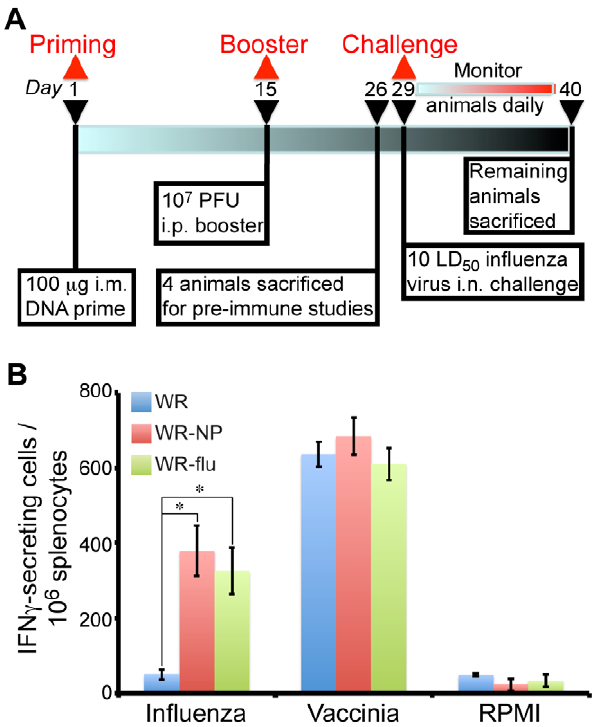
Figure 4. Immunogenicity of WR-NP and WR-flu in mice. (A) Immunization schedule. BALB/c mice were primed with 100 m g of DNA (either 100 m g pCIneo-NPmix or empty vector, or 50 m g pCIneo- NPmix + 50 m g pCIneo-HANA) intramuscularly (i.m.) at the start of the vaccination protocol. Two weeks later, the mice were boosted by intraperitoneal (i.p.) infection with 10 7 PFU of WR, WR-NP, or WR-flu. Eleven days post-boost, four mice were sacrificed to analyze the adaptive immune response. The remaining mice were challenged with influenza virus A/WSN/33, A/PR/8/34, or A/California/07/09. (B) Vaccine- elicited T cell responses of splenocytes 25 d after the start of the immunization protocol were measured in triplicate for each immuni- zation group by fresh IFN c ELISPOT assay following stimulation with influenza virus NP peptide TYQRTRALV, vaccinia virus E3 peptide VGPSNSPTF, or RPMI media alone. The results represent the mean number of IFN c -secreting cells per 10 6 splenocytes from three biological replicates 6 standard deviations. P values from a two-tailed t test assuming nonequal variance are indicated (*, P , 0.05).